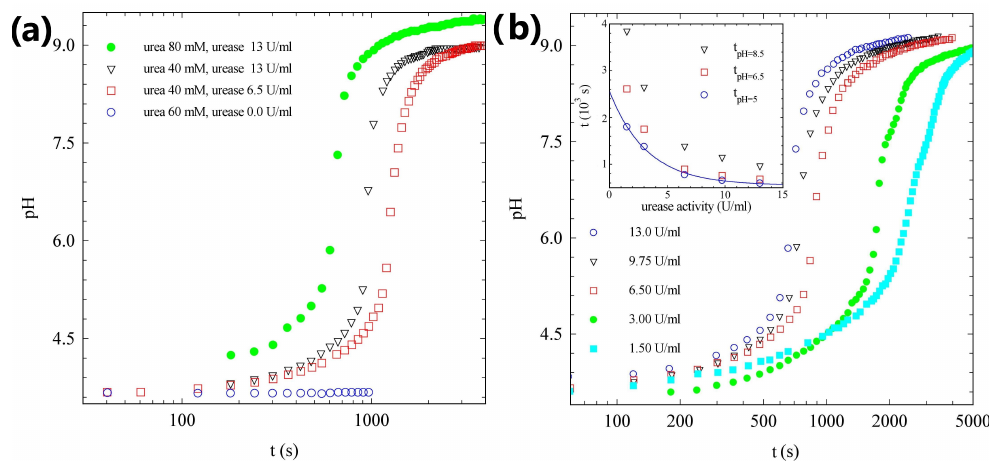
Figure 2. ( a ) Time evolution of the pH in the urea–urease reaction, for samples characterized by the same amount of acetic acid (0.012mM) but different concentrations of urea and urease, as indicated in the legend. ( b ) Time evolution of the pH in the urea–urease reaction, for samples characterized by the same amount of acetic acid (0.012mM) and urea (60mM), but different urease activity. Inset: time needed to reach pH = 5 (circles), pH = 6.5 (squares), and pH = 8.5 (triangles). The continuous line is an exponential